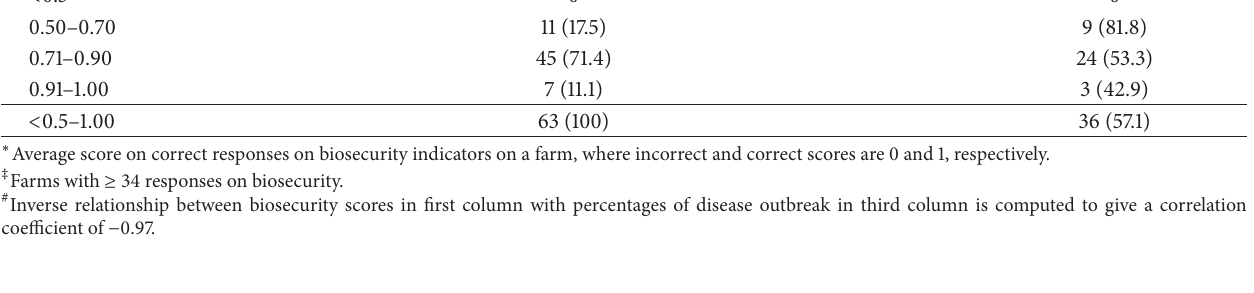
Table 5: Effect of housing system on the occurrence of disease outbreaks on